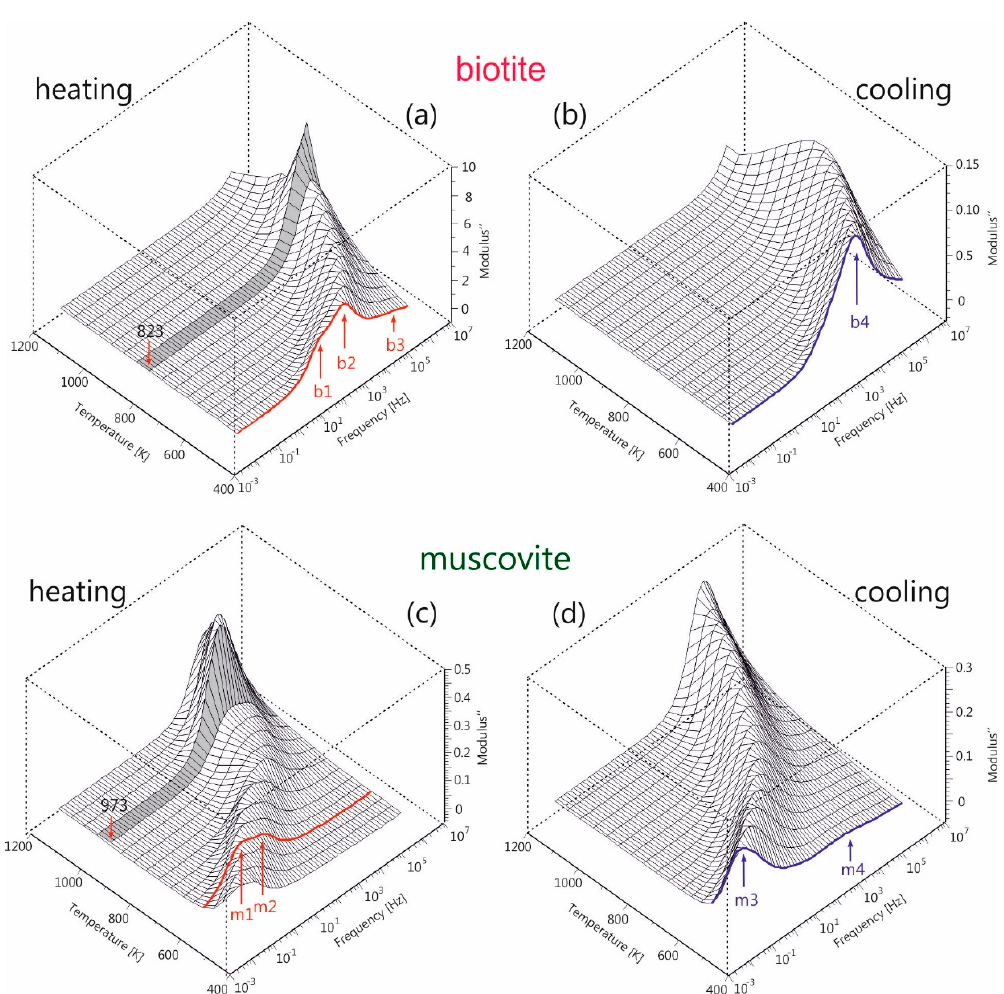
Figure 6. 3D-plane plots of imaginary part of electric modulus ( M ’’) as a function of frequency and temperature for biotite ( a , b ) and muscovite ( c , d ) mica, during gradual heating at 1173 K and subsequent cooling to 473 K. See text for details.